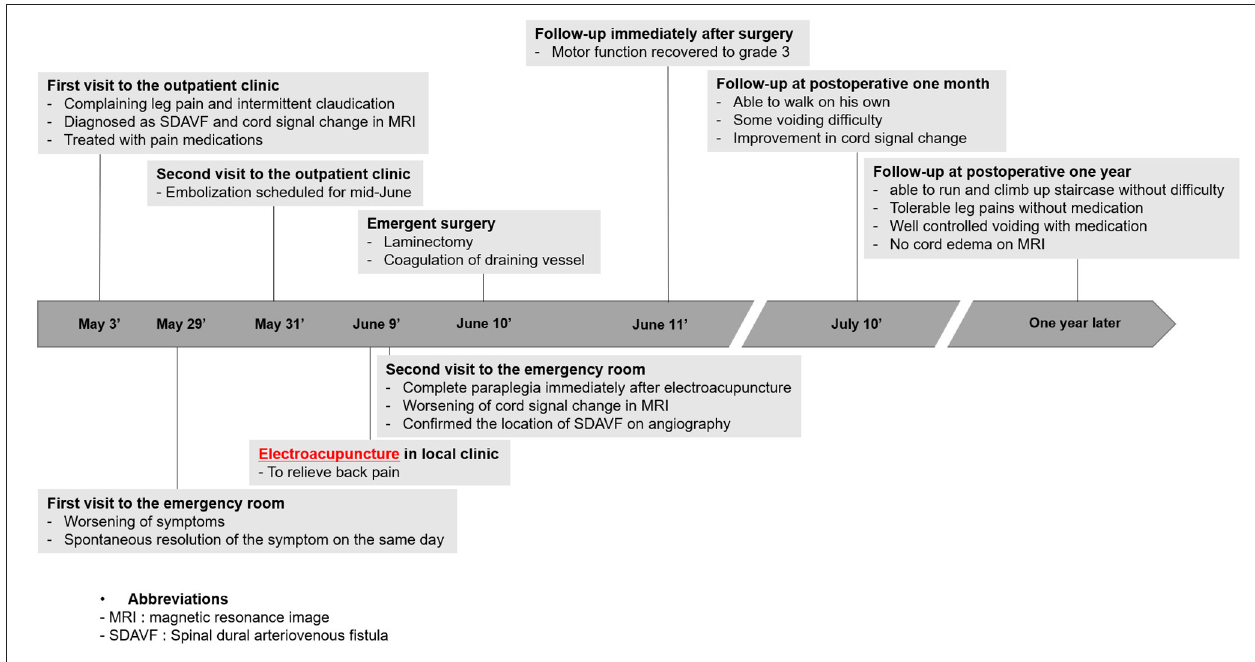
FIGURE 1 | Timeline of the current case.